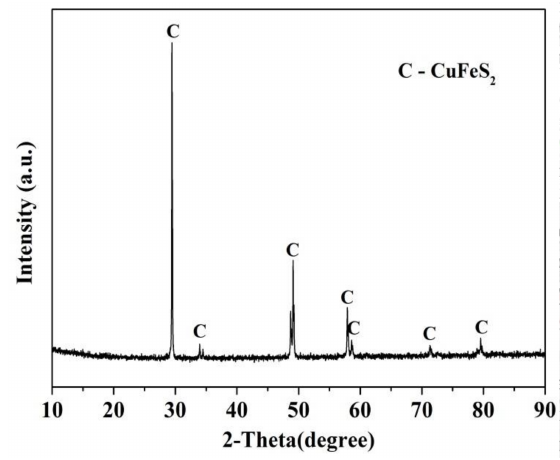
Figure 1. X-ray Diffraction patterns of